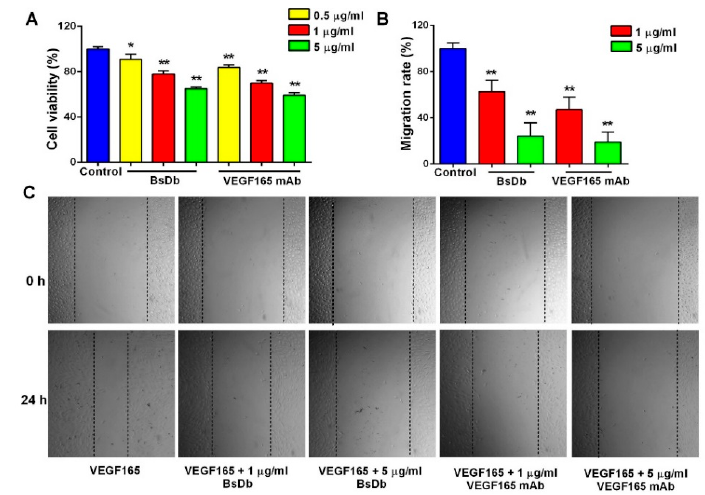
Figure 7. The recombinant BsDb inhibited VEGF-induced proliferation and migration of primary HUVECs. ( A ) BsDb inhibited the primary HUVECs proliferation. Primary HUVECs were cultured in 96-well plates and stimulated with 100 ng/mL VEGF165 and various concentrations of recombinant BsDb or VEGF165 mAb. Cell growth was then determined using an MTT assay. ( B , C ) BsDb inhibited the primary HUVECs migration. The HUVECs monolayer was scratched and placed in fresh Endothelial Cell Medium (ECM) containing 1% FBS with 100 ng/mL VEGF165 and various concentrations of recombinant BSDb or VEGF165 mAb. The HUVECs migration was photographed using a microscope after 24 h (40×) and the migration rate was calculated. The experiment was done in triplicate and the mean values ± SD were presented. * p < 0.05 and ** p < 0.01 using a two-tailed students t-test versus the control group. VEGF could promote endothelial tubular morphogenesis as a key angiogenic stimuli. To further confirm whether the recombinant BsDb was capable of inhibiting VEGF165 signaling, the HUVECs tube formation assay was used to assess the inhibitory effect of the BsDb in angiogenesis. These results showed that the recombinant BsDb and VEGF165 mAb remarkably decreased the total length of the tubes in a dose-dependent manner (Figure 8), suggesting an effective inhibitory function of the recombinant BsDb against VEGF165-stimulated tube formation in HUVECs.